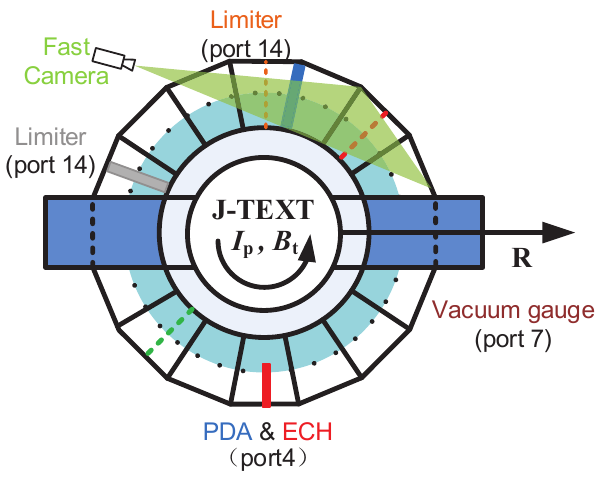
Figure 1. Distribution of related diagnostics and the ECH system on J-TEXT from a top view.